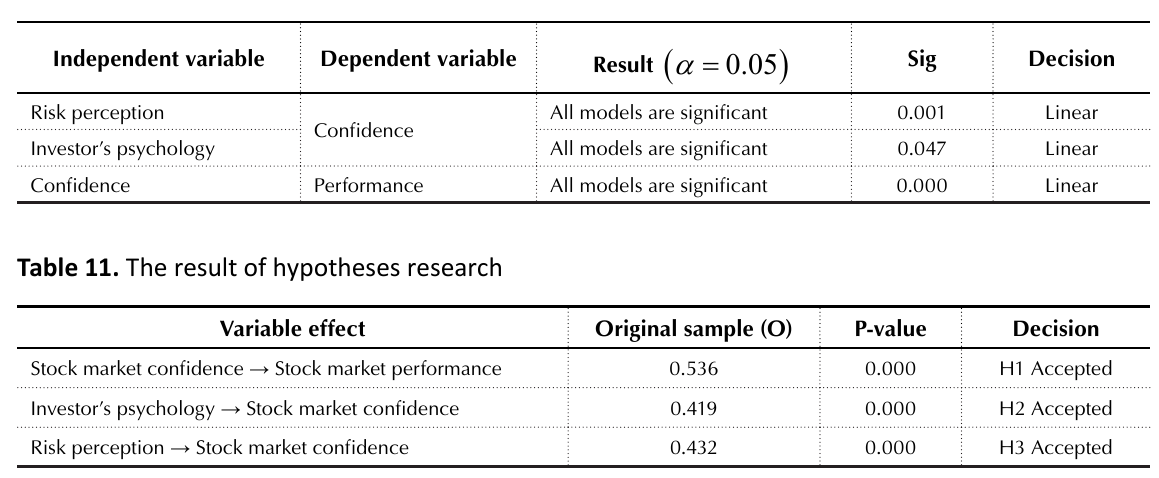
Table 10. Linearity